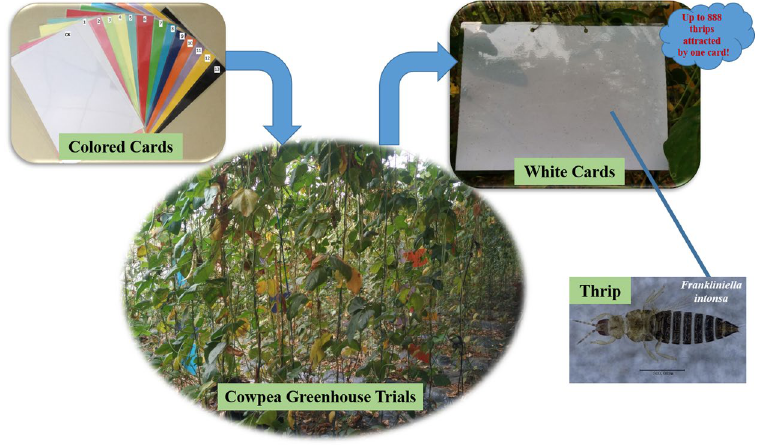
Figure 3. The colored cards field trials